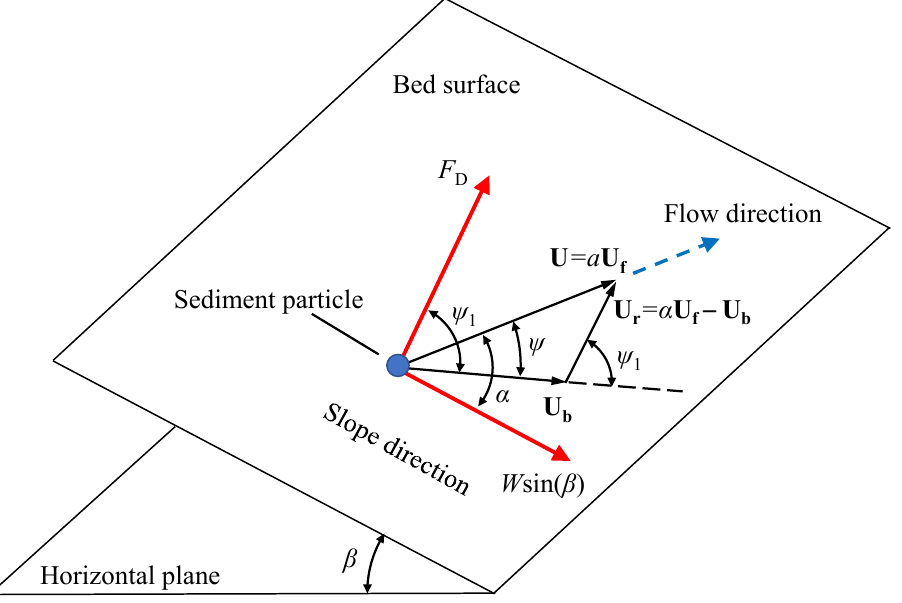
where µ s = tan ϕ s is the static friction coefficient, and ϕ s is the static repose angle of the sediment particles. sediment particles.